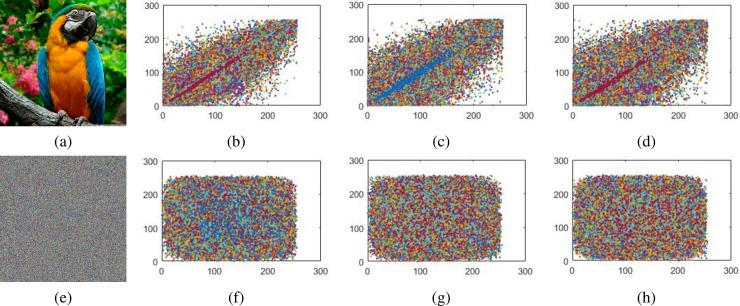
Correlation coefficient between pixel pairs for original and encrypted Parrot image.(a) Plain Parrot image. (b) Horizontal correlation. (c) Vertical correlation. (d) Diagonal correlation. (e) Encrypted Parrot image. (f) Encrypted Horizontal correlation. (g) Encrypted Vertical correlation. (h) Encrypted Diagonal correlation.